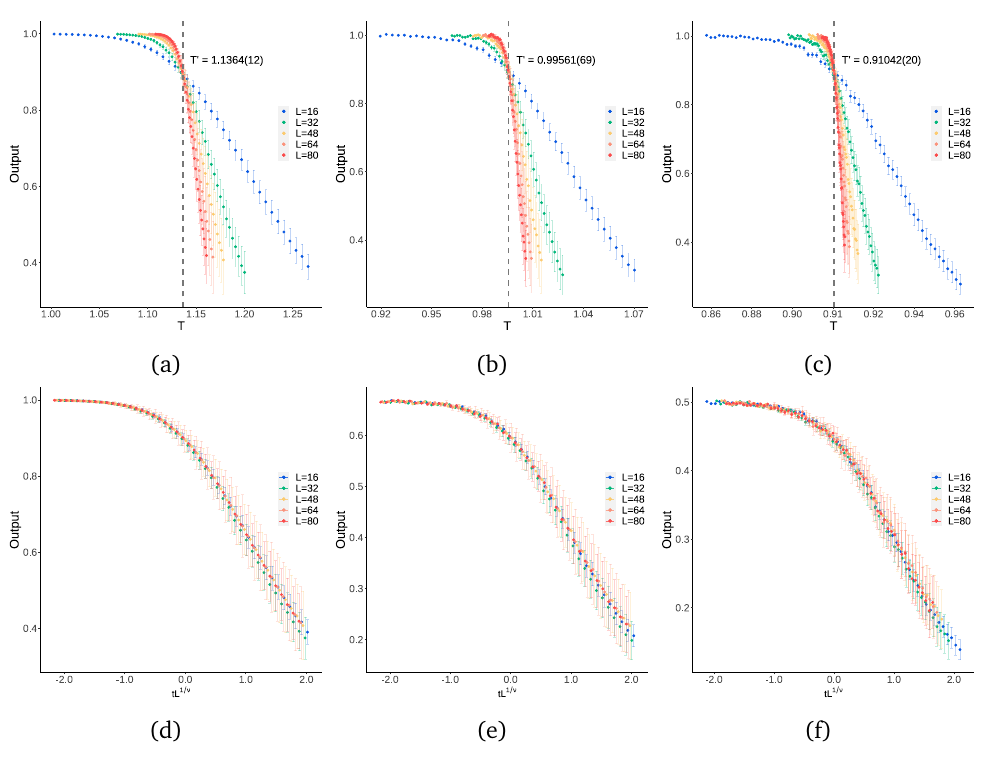
Figure 4: Exponential reduction of the state space of training data. a–c , Average q / 2-normalized outputs of ANNs trained with the reduced state space versus sam- pling temperature for spin configurations of the Potts models with q = 2 ( a ), q = 3 ( b ) and q = 4 ( c ). d–f , Finite-size scaled results of a–c . The error bars shown are 99.7% confidence